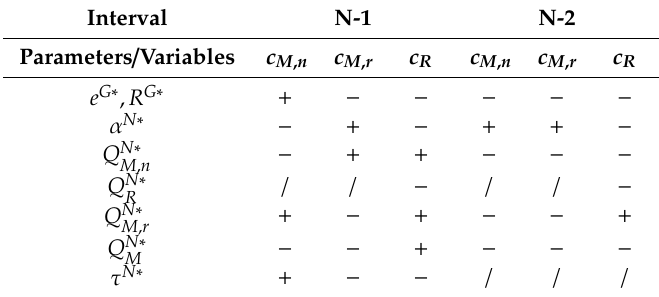
Table 3. Relationships between variables and parameters in model